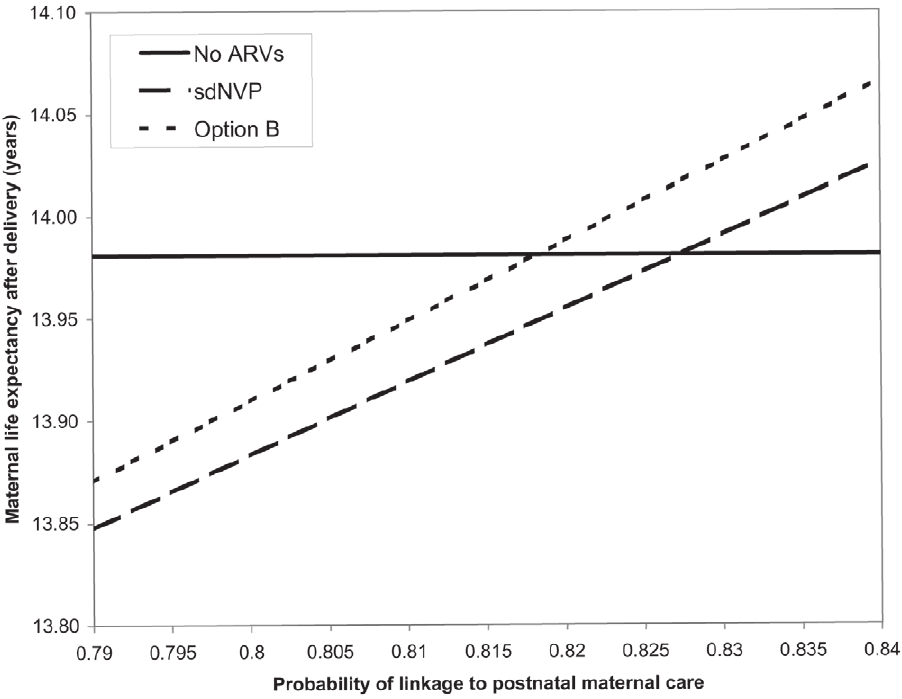
Figure 3. Sensitivity analysis demonstrating the impact on maternal life expectancy of rates of linkage to postnatal HIV care. The vertical axis represents maternal life expectancy, in years from delivery. The horizontal axis depicts the probability of linkage to postnatal HIV care for women who receive the PMTCT regimens shown. This probability of linkage to care is varied from 79% (the base case value) to 85%. In the base case, maternal life expectancy following the sdNVP and Option B regimens is lower than if no antenatal ARVs were received for PMTCT (triangles). This occurs as a result of modeled negative impacts of sdNVP-associated resistance (sdNVP regimen) and ART interruption (Option B regimen). When the probability of linkage to care following Option B is $ 81.8%, as indicated by the open arrow (2.8% more than if no antenatal ARVs are received), the negative impact of ART interruption is overcome. Similarly, when the probability of linkage to care following sdNVP is $ 82.8%, as indicated by the solid arrow (3.8% more than if no ARVs are received), the negative impact of sdNVP-associated resistance is